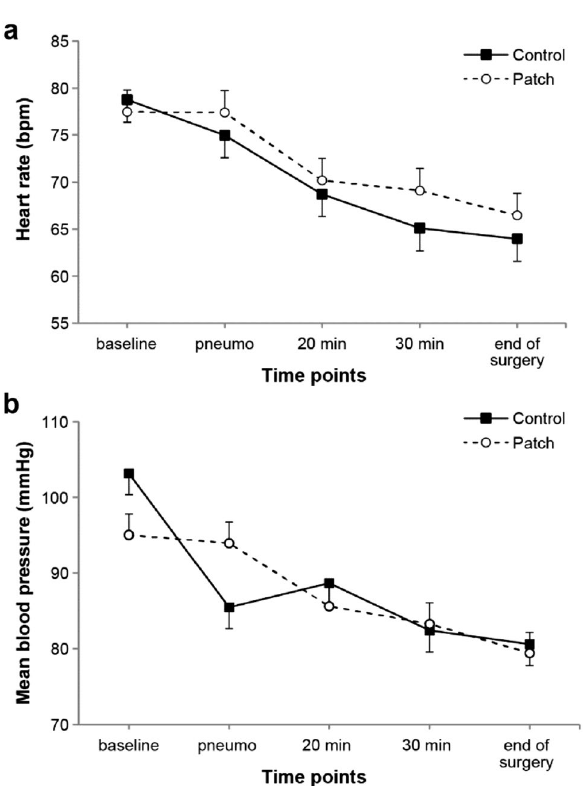
Figure 2. Changes of heart rate ( a ) and mean blood pressure during surgery ( b ). Values were expressed as mean ± standard error. Baseline before anesthesia induction, pneumo at pneumoperitoneum, 20 min 20 min after pneumoperitoneum, 30 min 30 min after pneumoperitoneum, end of surgery 10 min before the end of